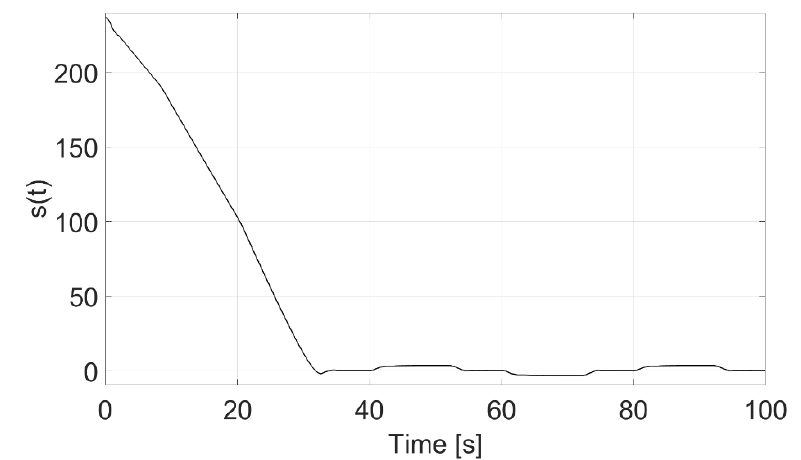
Figure 7. Sliding variable with the non-switching controller.